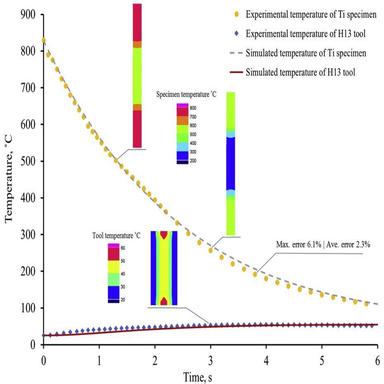
Comparison between the temperature histories of the Ti-6Al-4V and H13 obtained from the experiment and simulation.